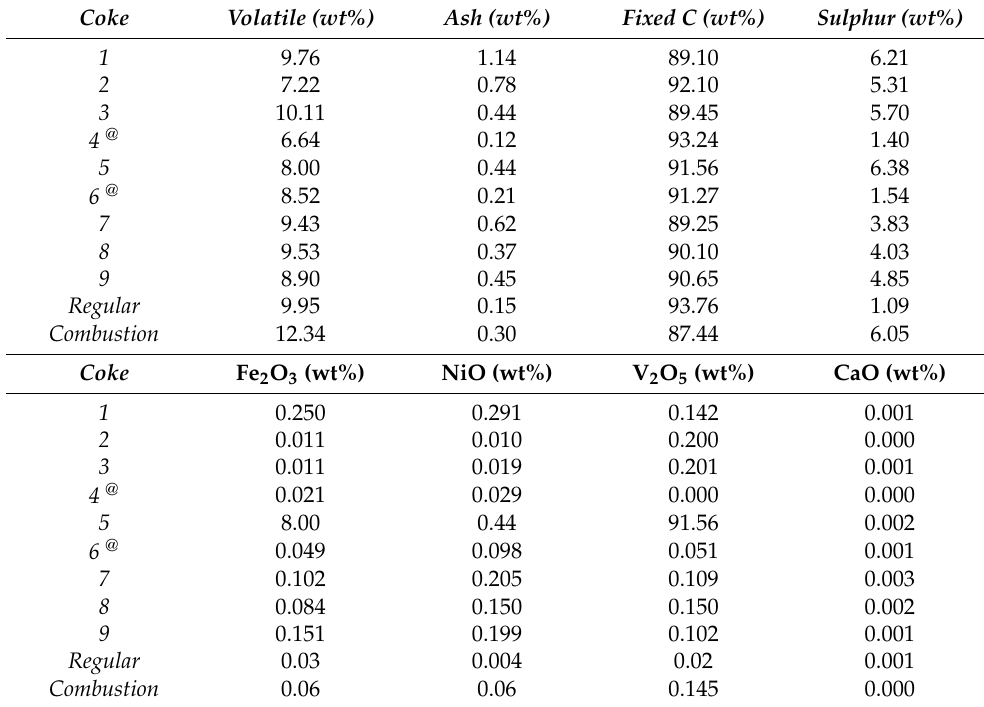
Table 2. Analysis of different green petroleum cokes used in this